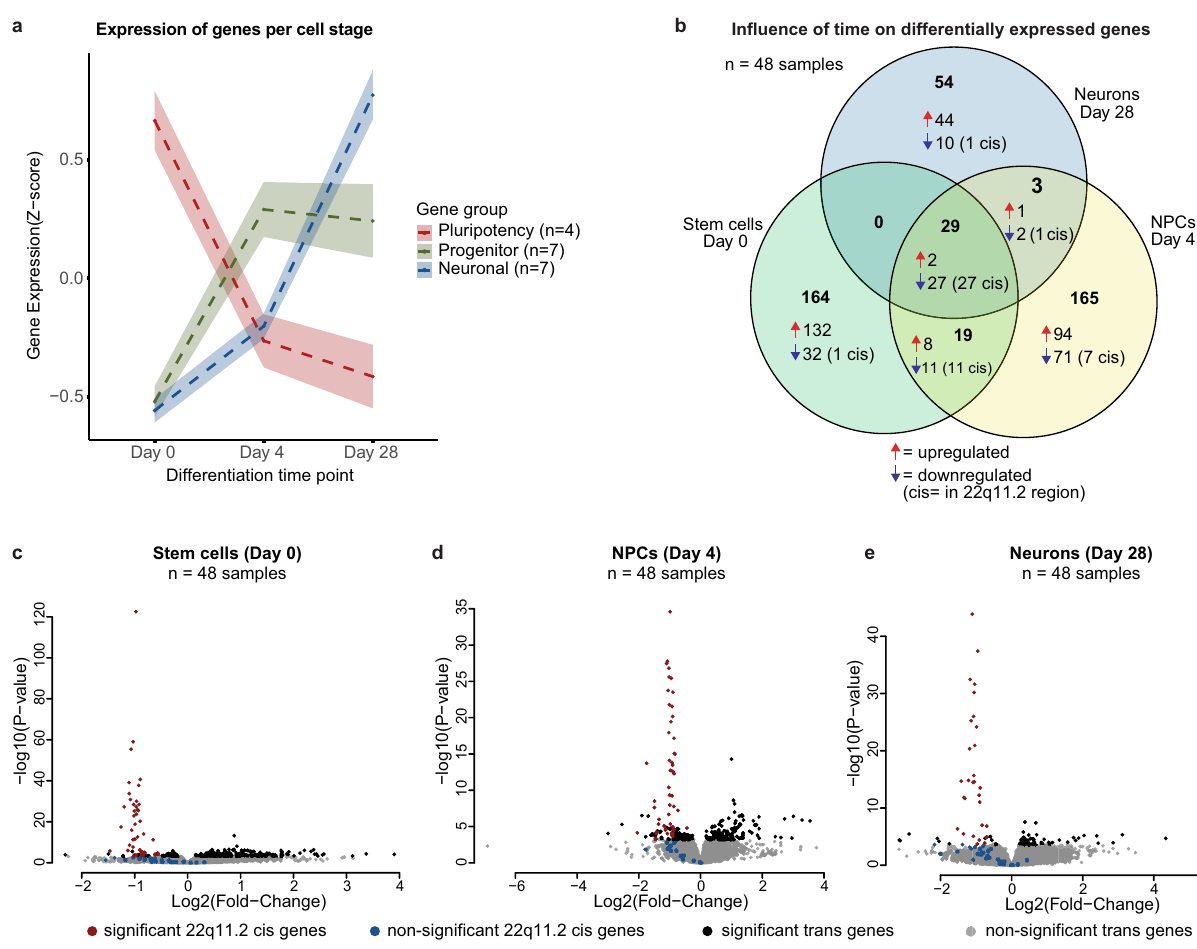
Fig. 2 Cell-type-speci fi c effects of the 22q11.2 deletion. a Expression of selected marker genes and 95%-con fi dence interval of the mean for de fi ned speci fi c cell stages by suppression of genes related to pluripotency ( SOX2 , OCT4 , NANOG , MKI67 ) and up-regulation of genes characteristic for neural progenitor cells ( NEUROD1 , SOX2 , EMX2 , OTX2 , HES1 , MSI1 , MKI67 ) and mature neurons ( NEUN , SYN1 , DCX , MAP2 , TUJ1 , NCAM , MAPT ) as the differentiation progresses. b Venn Diagram highlighting the number and directionality of shared and unique differentially expressed genes (FDR <5%) between deletion carriers and controls at each cell stage. Genes within the deletion region (cis) are mostly shared across development stages, whereas genes outside the deletion region (trans) are cell-stage speci fi c. c – e , Volcano plots showing differential gene expression in stem cells ( c ), NPCs ( d ) and neurons ( e ) Signi fi cantly differentially expressed genes (FDR <5%) within the deletion region are presented in red and outside deletion in black. Non-signi fi cant genes in deletion region are presented in blue. The test statistics were derived from Wald-test in DEseq2 and are presented in Supplementary Data 1 –